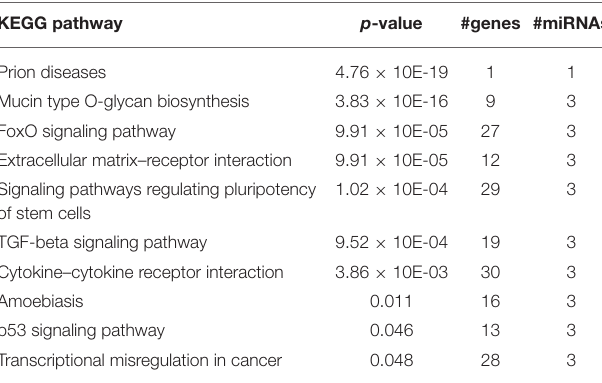
TABLE 3 | Top pathways ( p < 0.05) enriched for genes targeted by let-7b-5p, miR-223-3p, and/or miR-130a-3p. KEGG pathway p -value #genes #miRNAs